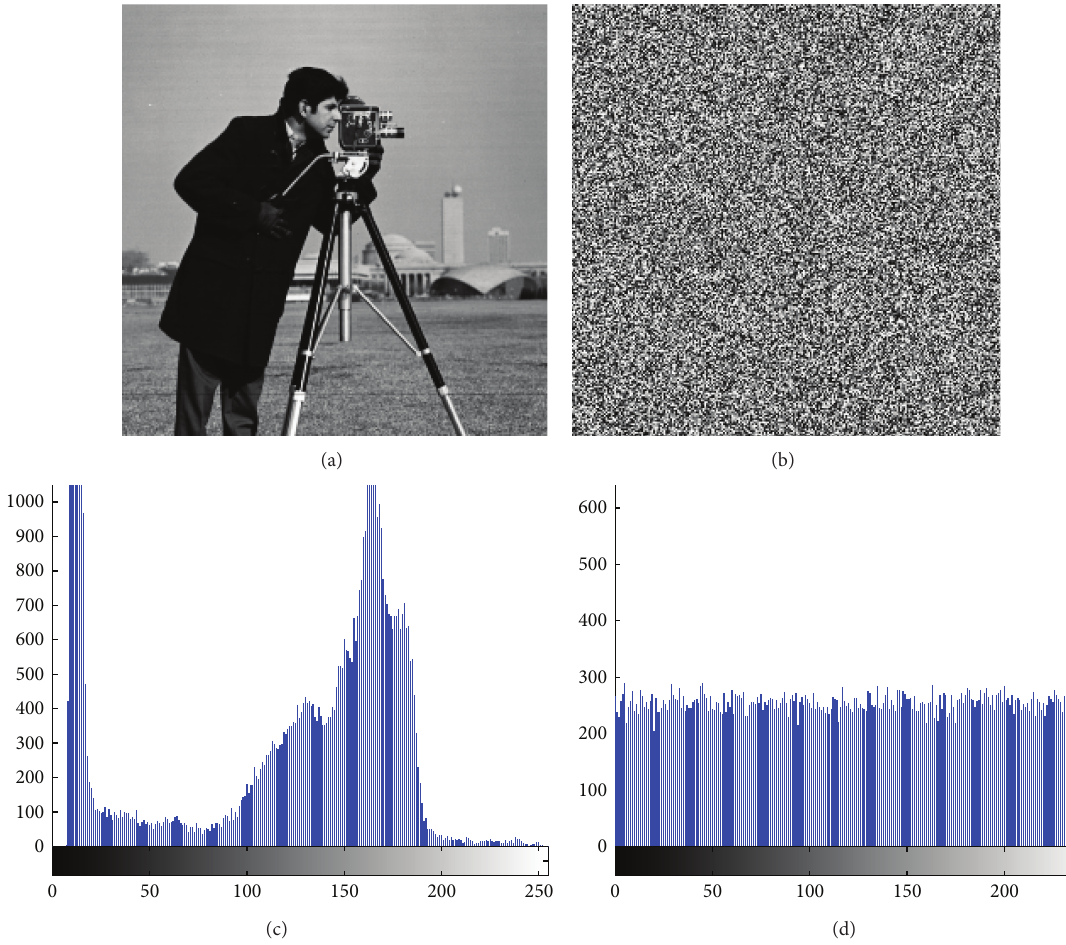
Figure 3: Histogram plots: (a) plain-image, (b) cipher-image, (c) histogram of (a), and (d) histogram of (b).